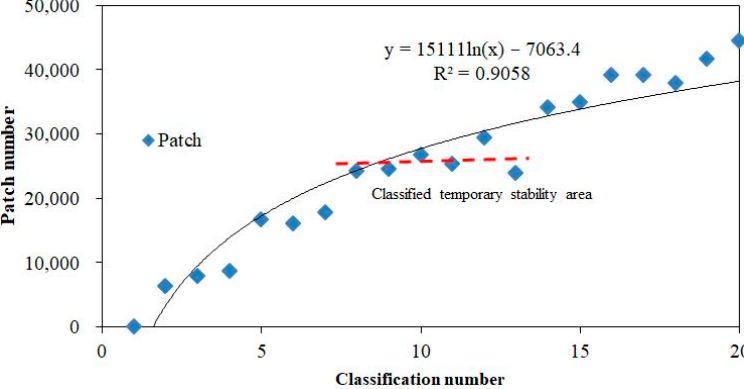
Figure 6. Relationship between classification number and patch number.